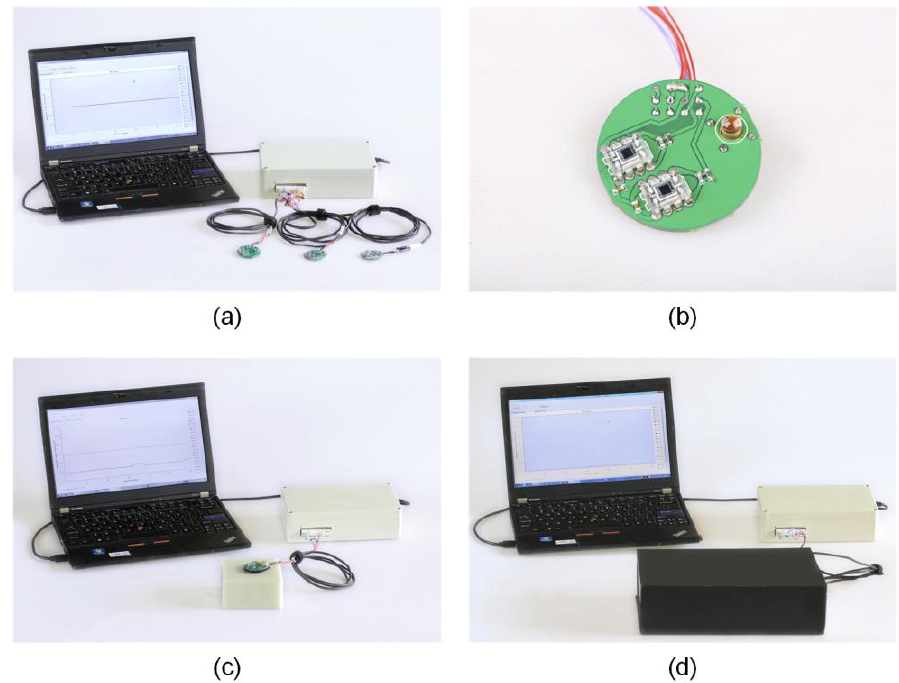
Figure 1. Near-infrared spectroscopy (NIRS) device. ( a ) Three parts of the device: the software in a computer, the three probes, and the functional module; ( b ) a probe with one light-emitting diode (LED) source and two sensors; ( c ) a device with the probe stuck on the solid phantom; ( d ) a device working with the probe and phantom inside a full dark box.